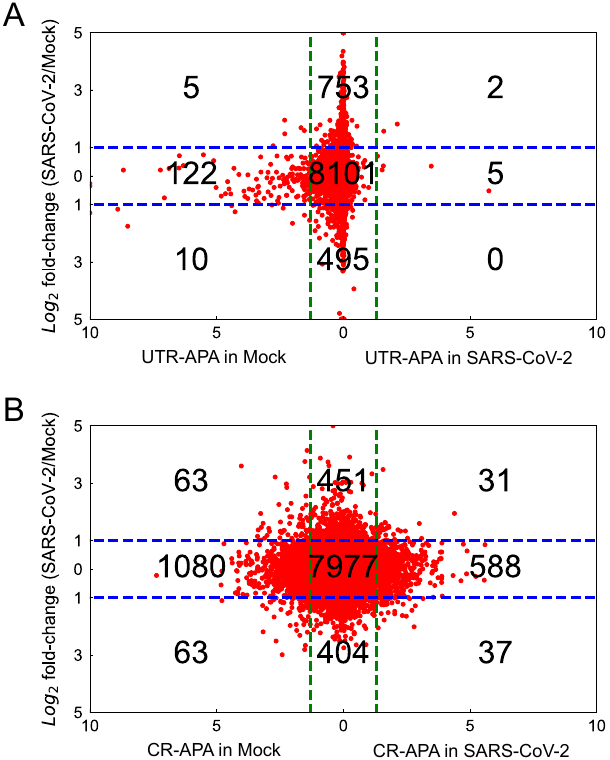
Figure 8. Scatter plot of APA and differential gene expression. Red dots represent the individual gene in the analysis. Horizontal blue-dashed lines represent the cutoff values for two-fold changes in differential gene expression. Vertical green-dashed lines represent the cutoff values for the log 10 ( p -value) of UTR-APA ( A ) determined by the Chi-squared test, and the log 10 ( p -value) of CR-APA ( B ) determined by the Student’s t